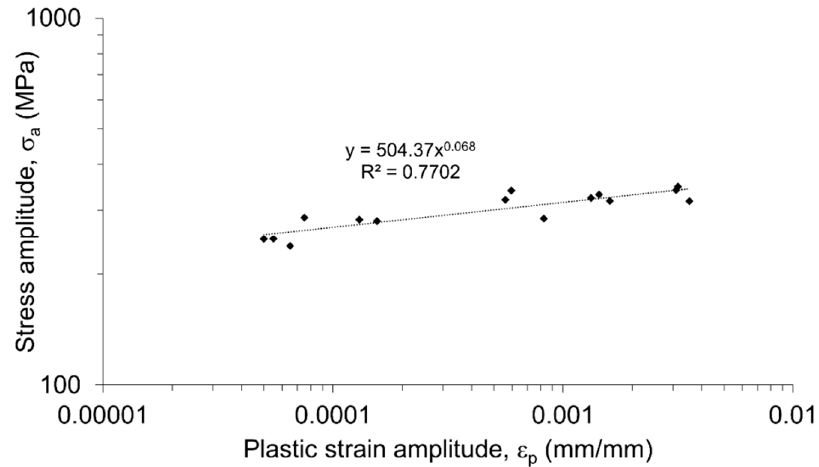
Figure 14. Stress amplitude versus plastic strain amplitude of FSW joint stabilized hysteresis loops in log-log coordinates.